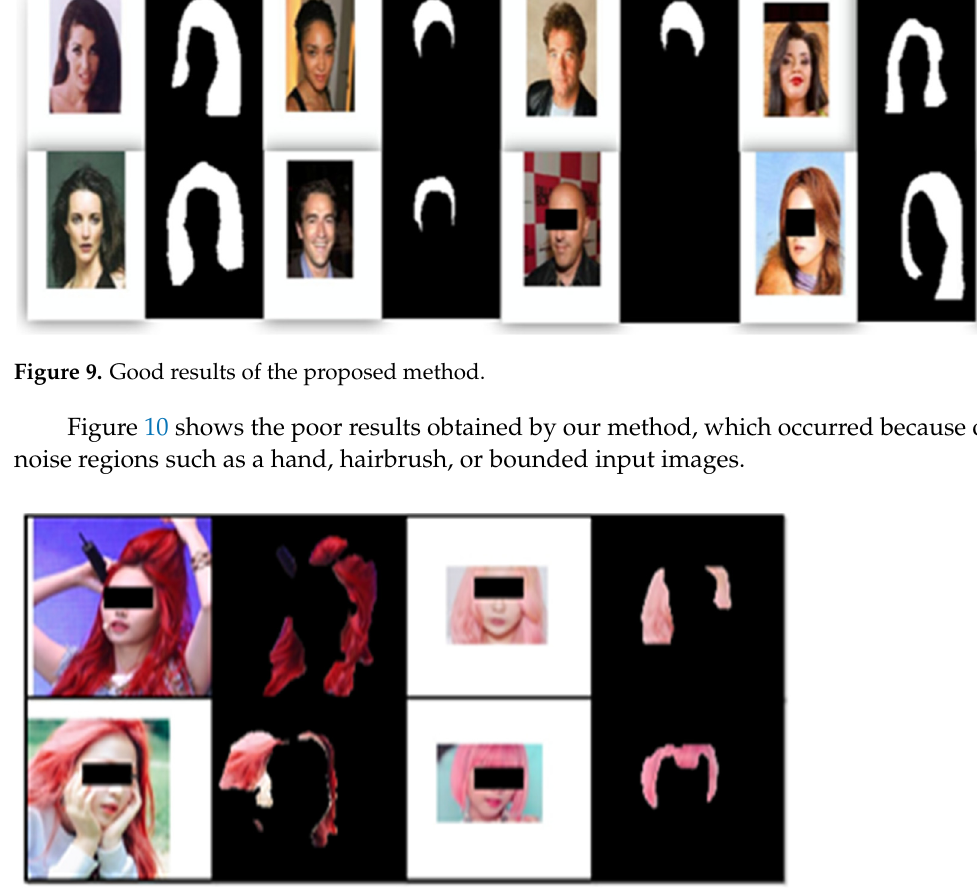
Figure 10. Poor results of the proposed method.